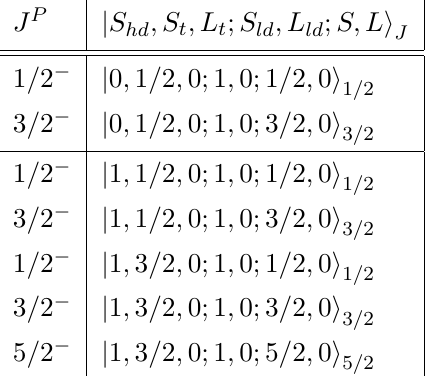
Table 2 . Spin-parity J P and state vectors of the S -wave pentaquarks containing the \good" light diquark with the spin S ld = 0. The horizontal line demarcates the spin S hd of the heavy diquark.